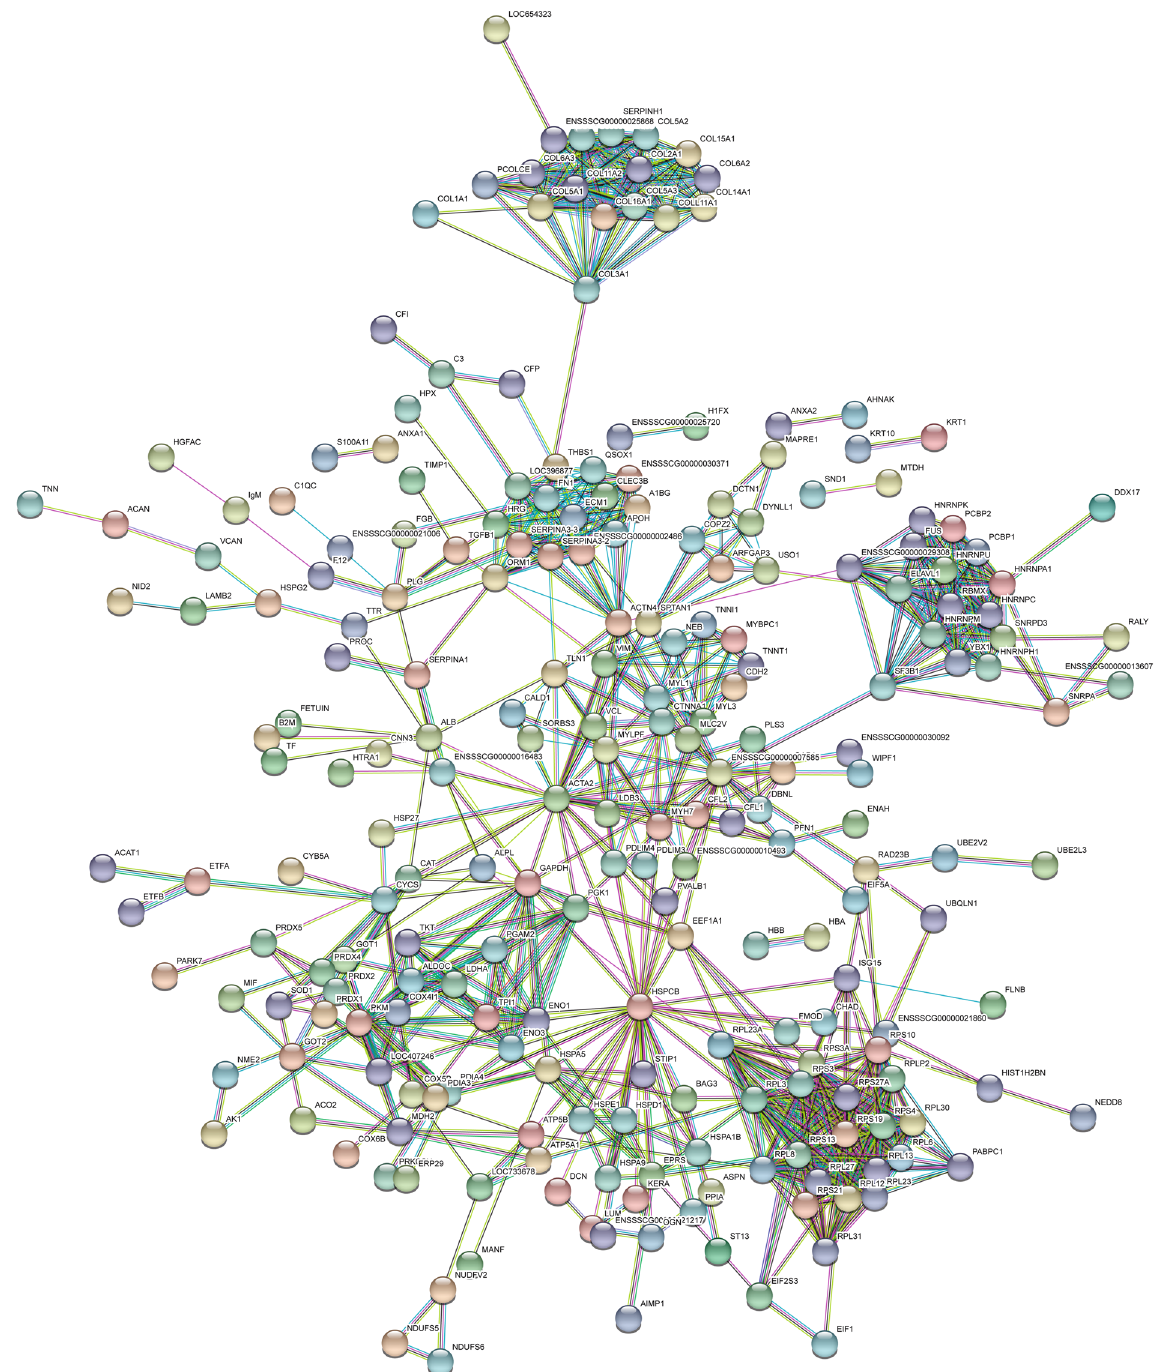
Figure 2. STRING representation of a network involving the proteins detected in ABL. Different line colors represent the types of evidence for the association between